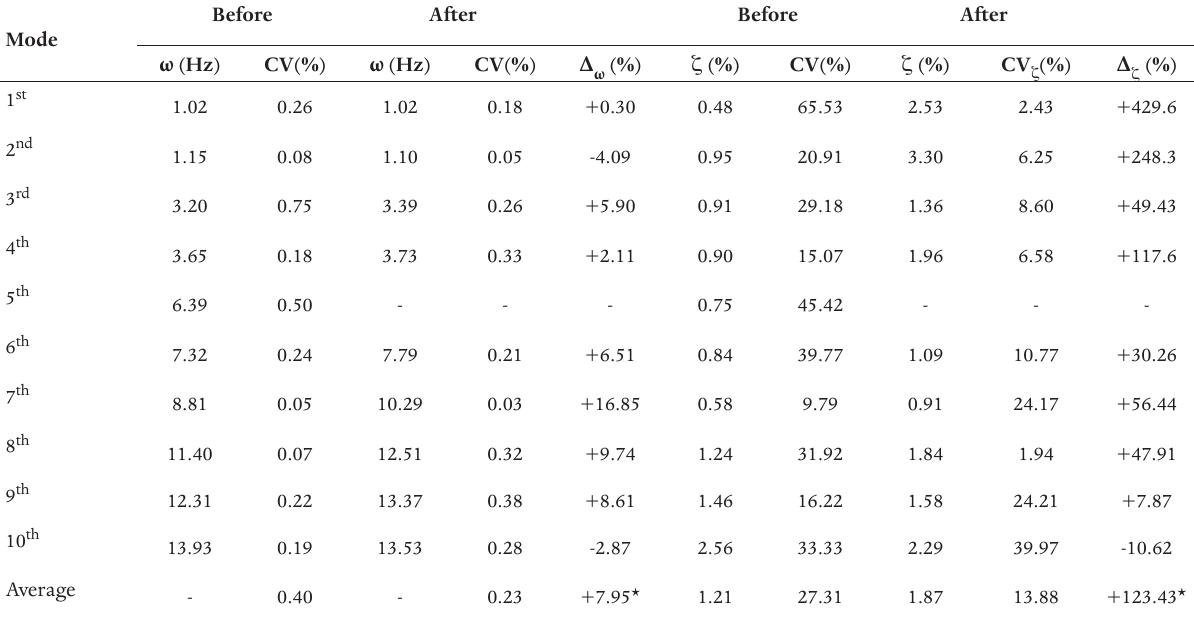
Table 2. Comparison of estimated frequency values and damping coefficients before and after the rehabilitation works.